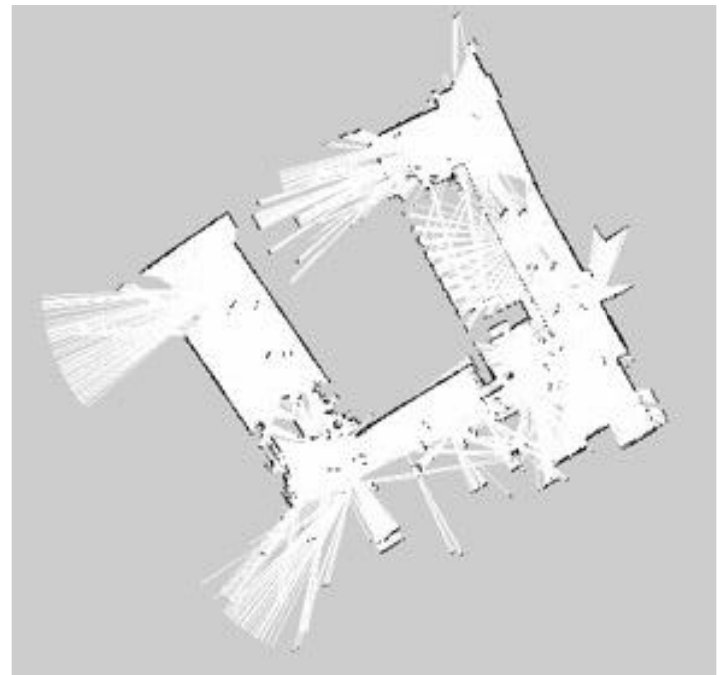
Figure 23. The map using Gmapping (YDLiDAR X4).